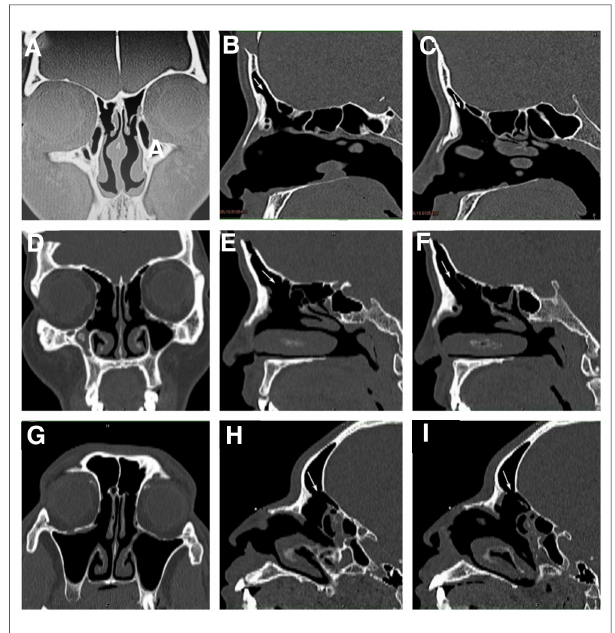
FIGURE 3 Thin slice CT examination of paranasal sinus in patient 1, 2 and 3 after operation: patient 1 ( A – C ), patient 2 ( D – F ), patient 3 ( G – I ), coronal ( A , D , G ), sagittal left ( B , E , H ) and right ( C , F , I ). The arrow indicates the opening of frontal sinus and the drainage channel of frontal